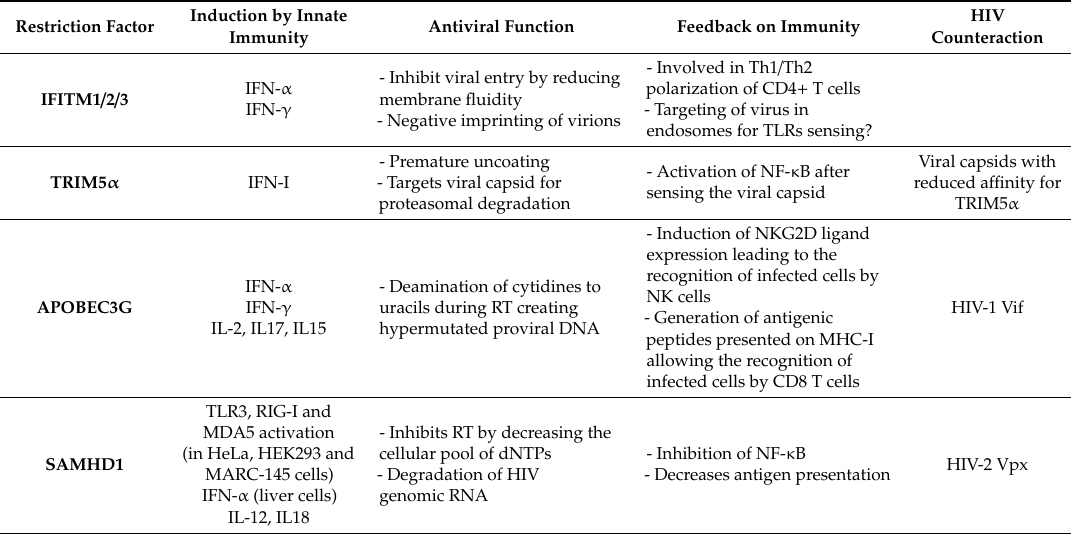
Table 1. Overview of the interplay between restriction factors and